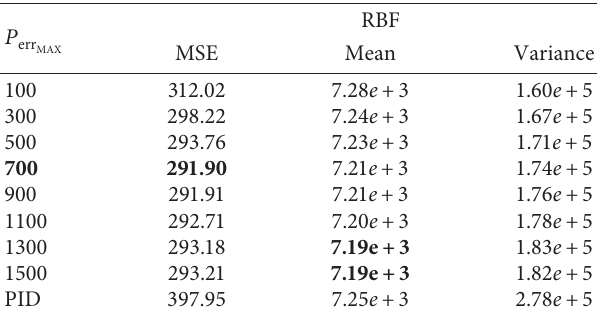
Table 4: Variation of MSE, output power mean, and variance with P . err MAX